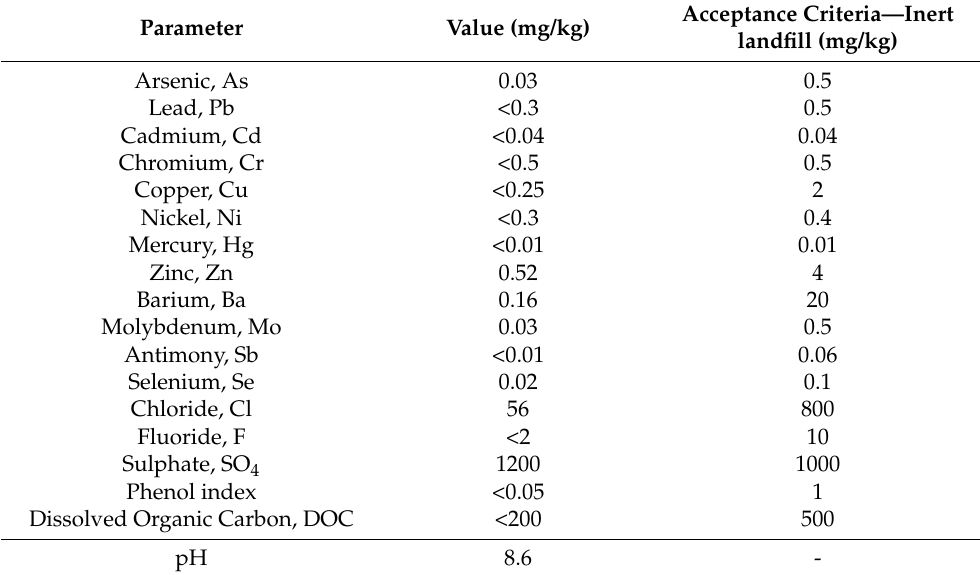
Table 3. Results of laboratory leaching tests of the recycled C&D material and corresponding acceptance